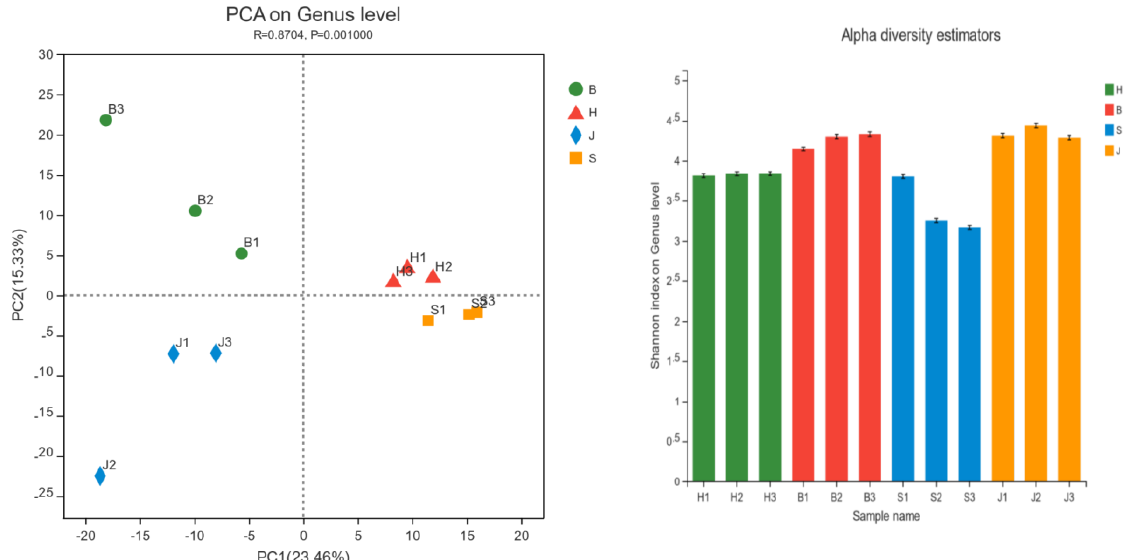
Figure 2. Alpha Shannon index diagram/PCA analysis diagram. (H represents the Hechuan District, S represents the Shapingba District, J represents the Jiangbei District, and B represents the Beibei District).